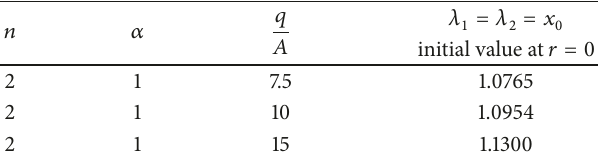
Table 1: The initial value of governing equations with the variation of 𝑞/𝐴 .